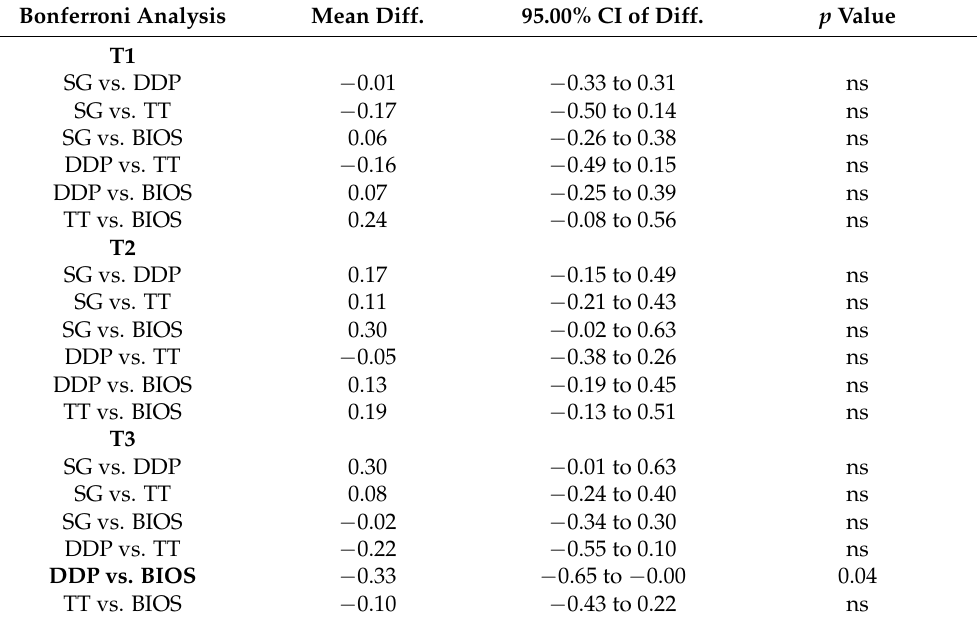
Table 3. Bonferroni multiple comparison test considering the exposition to the different materials. Bonferroni